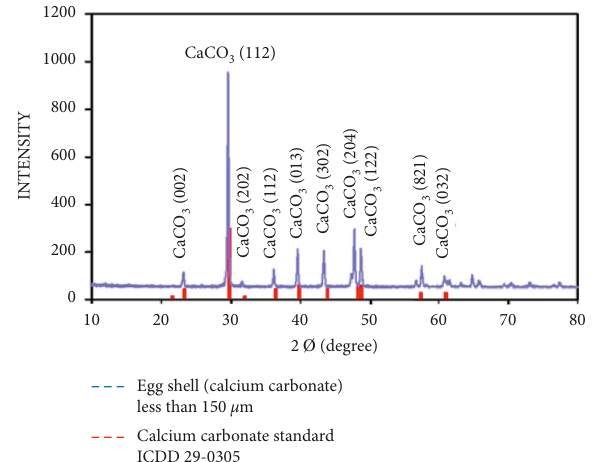
Figure 6: X-ray diffraction pattern for the eggshell particle size of 150 μ m.